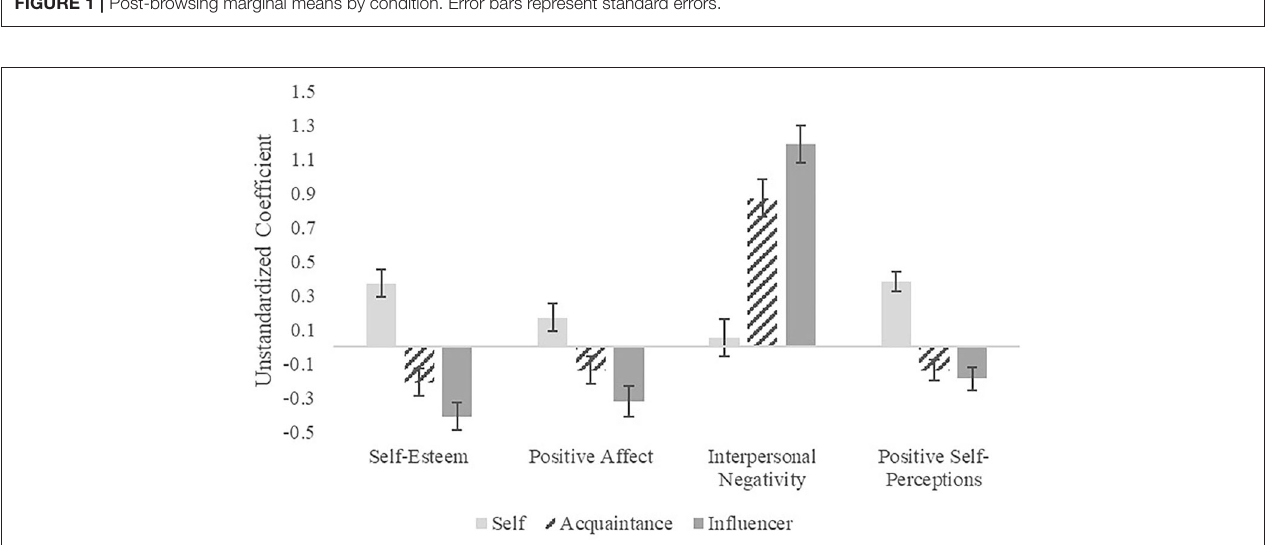
FIGURE 1 | Post-browsing marginal means by condition. Error bars represent standard errors.